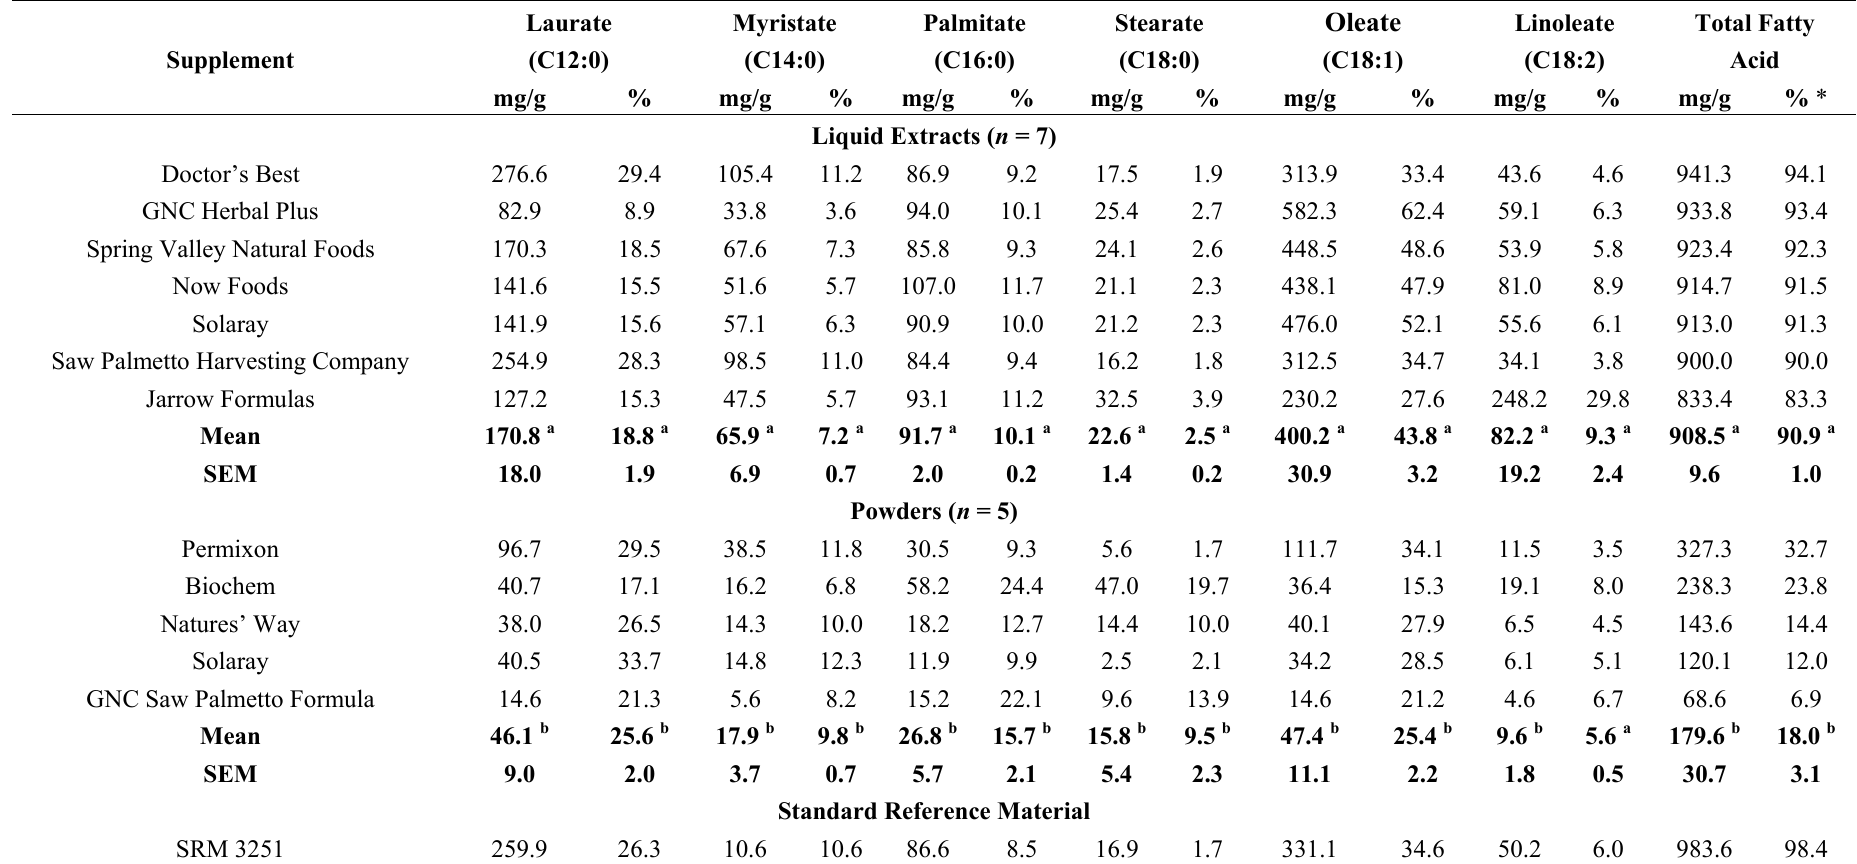
Table 2. Fatty acid quantities (mg/g) and composition (% of total fatty acids) in SRM, liquid, and powder saw palmetto supplements. Supplement